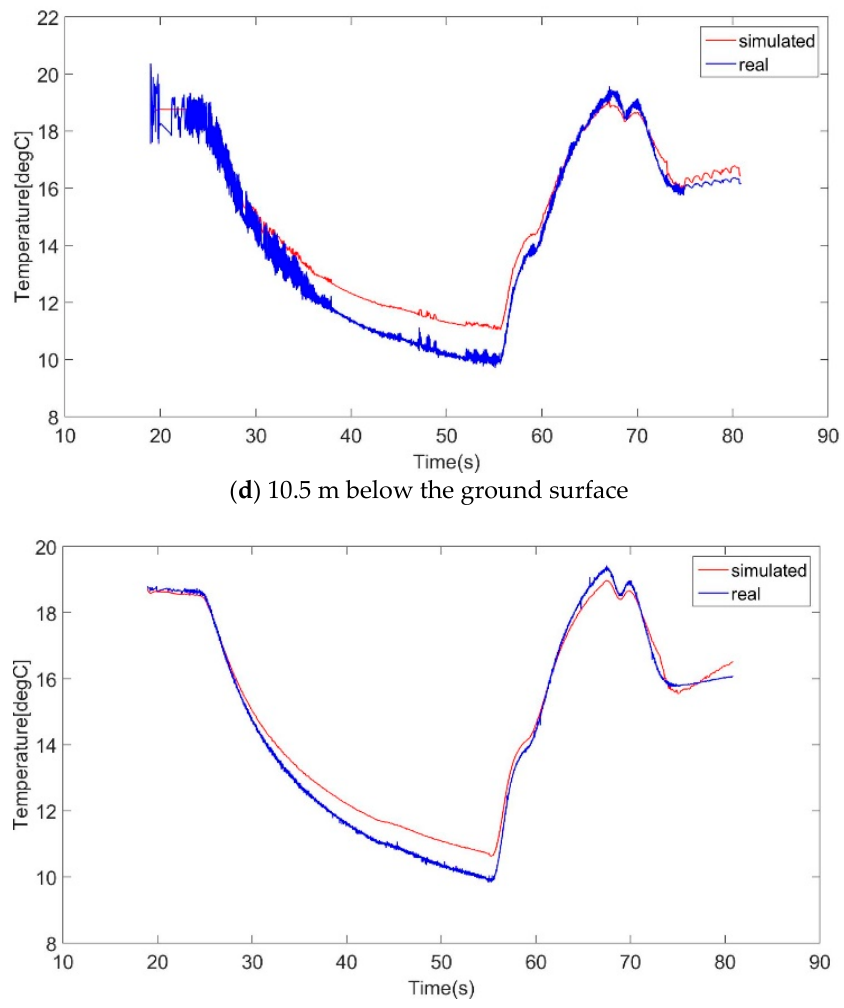
Figure 10. Temperature profiles in the borehole when the heat transfer coefficient across the concrete–soil surface was 4 W/m 2 K.